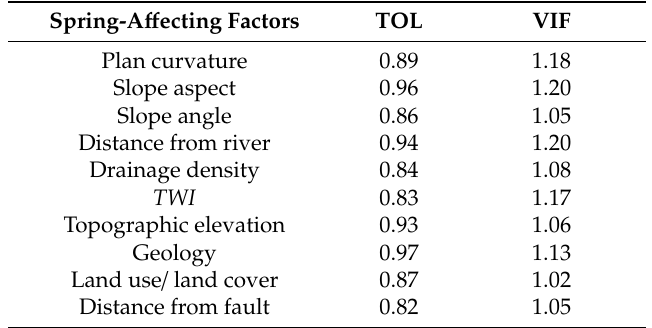
Table 2. Indices of multi-collinearity diagnosis for independent variables used in logistic regression (LR)